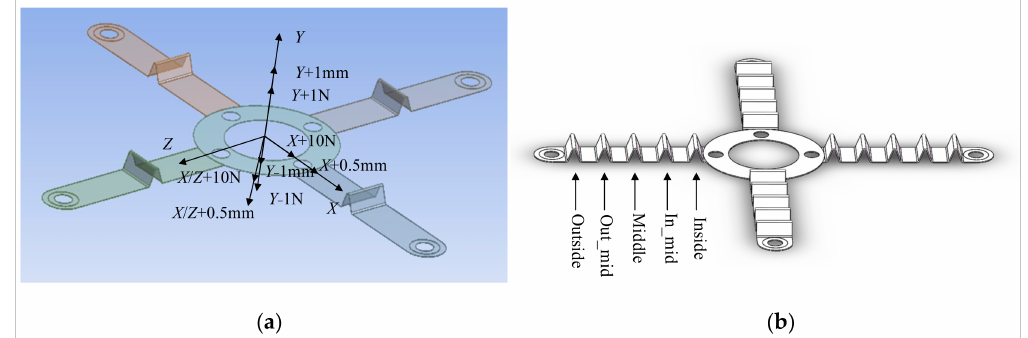
Figure 5. Simulation parameters of BBR ( a ) Driving direction of force and displacement. ( b ) Bending position. In Figure 5a, (1) Y + 1 N: Apply a force of 1 N in the Y -direction to calculate the displacement of the BBR. (2) Y − 1 N: Apply a force of − 1 N in the Y -direction to